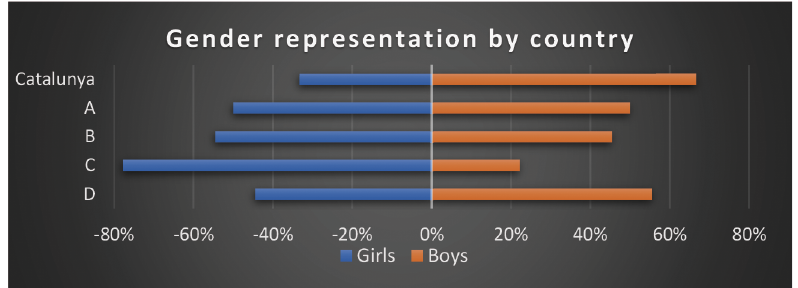
Figure 1. Participating students by gender